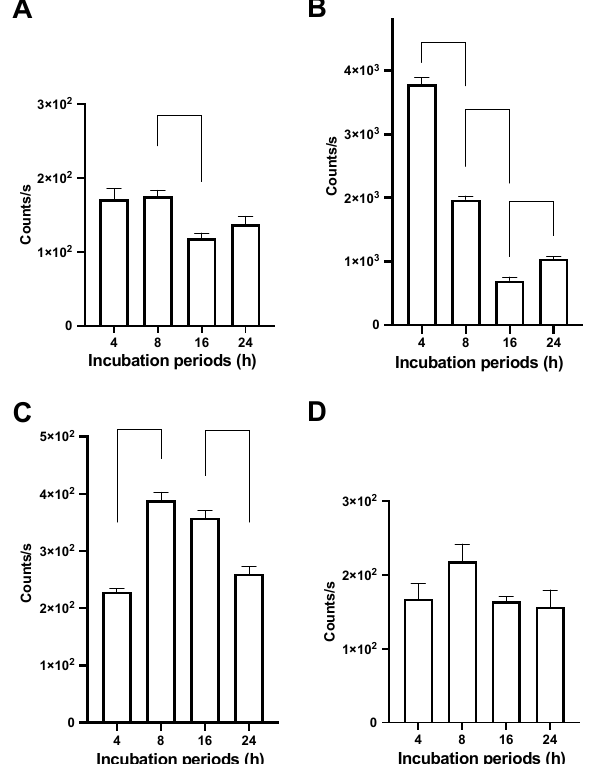
Figure 4. Bioluminescence analysis of time-dependent cellular uptake of THP-engineered PalmReNL-EVs by MDA-MB-231 cells. Bioluminescence analysis of the recipient MDA-MB-231 cells cultured with PalmReNL-EVs bearing DOPE-lipid nanoprobes only ( A ), uPAR-binding ( B ), PDL1-binding ( C ), or EGFR-binding ( D ) at 4, 8, 16, and 24 h post-incubation. ( A – D ) Error bars, SD ( n = 5); two-sided Student’s t -test was used for comparison.